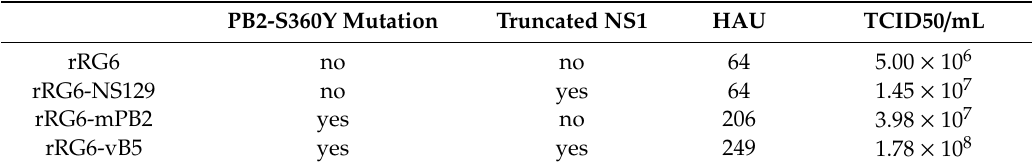
Table 3. The peak titers of reassortant viruses carrying PB2-S360Y or truncated NS1. PB2-S360Y Mutation